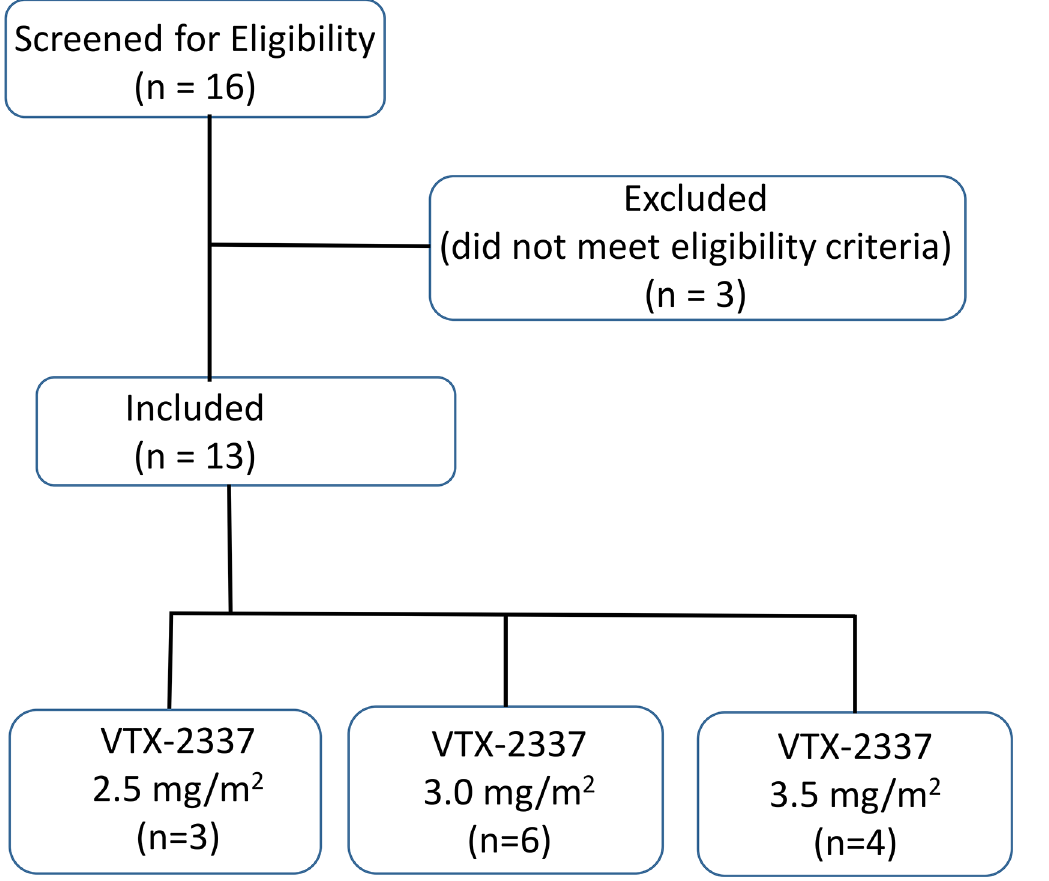
Fig 1. CONSORT Flow Diagram for Phase 1 clinical study in adult patients with advanced recurrent squamous cell carcinomas of the head and neck (SCCHN). Study subjects received VTX-2337 administered by the SC route on days 1, 8 and 15 of a 28-day treatment cycle. The first cohort received a 2.5 mg/m 2 dose of VTX-2337 following cetuximab administration; this dose was escalated in subsequent cohorts using a 3+3 design to 3.0 mg/m 2 and finally 3.5 mg/m 2